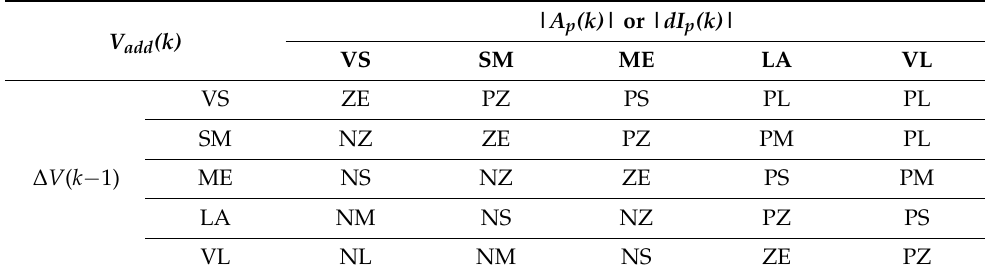
Table 4. Fuzzy association rules for FLC-1.